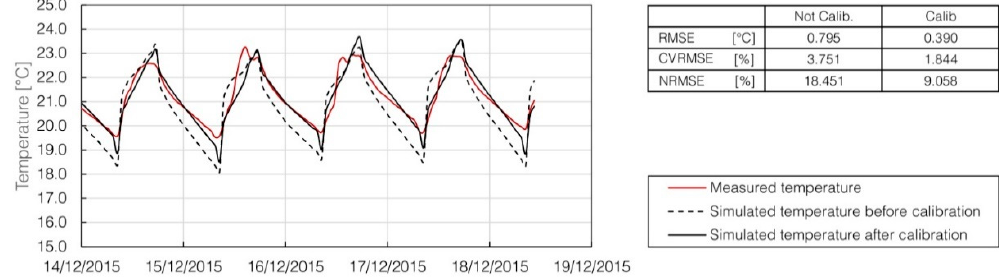
Figure 16. Results for Calibration C. First floor, North-West exposure.